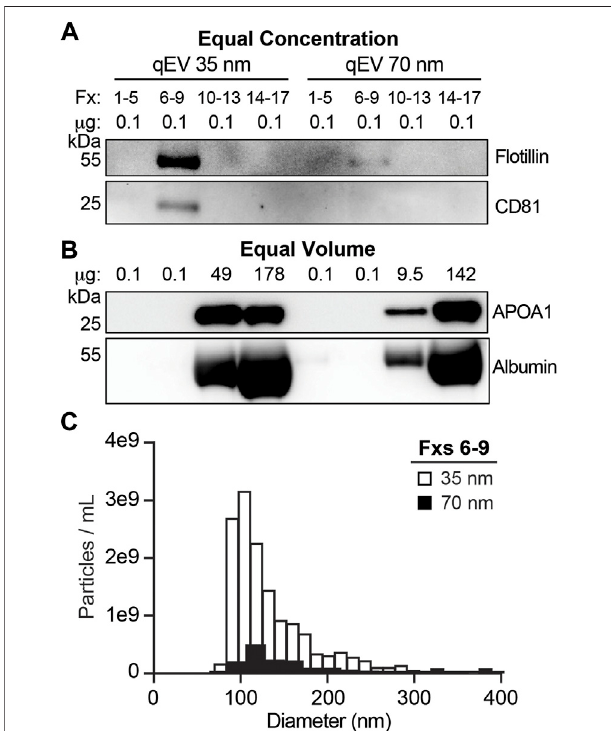
FIGURE 3 | SEC qEV single 35 nm columns are optimal for separating CSFEVs.PoolsofSECfractions(Fxs):1 – 5(columnvoid volume),6 – 9,10 – 13, and 14 – 17 were generated using either the qEV Single 35 nm or 70 nm columns. (A) Equal concentration loading of protein lysate (0.1 µg) from SEC pools immunoblotted for fl otillin and CD81. (B) Equal volume loading of proteinlysate(37 µL)fromSECpoolsimmunoblottedforAPOA1andalbumin. (C) Size and concentration histograms of Fxs 6 – 9 generated using either the qEV Single 35 nm (white) or 70 nm (black) columns acquired by tunable resistive pulse sensing